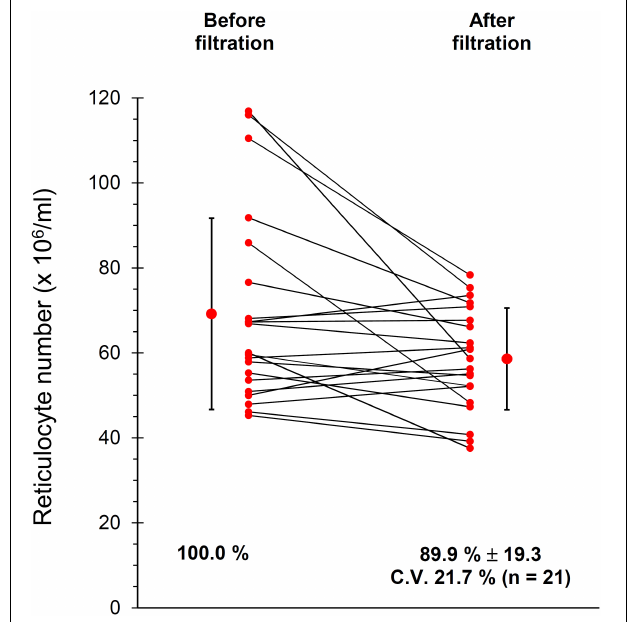
FIGURE 1 | Recovery of Retics after filtration of whole blood through cellulose. Samples of cells as suspensions of approximately 20% Ht, before and after filtration through cellulose were analyzed in 21 independent experiments as described in Materials and Methods section. An average of approximately 10% of Retics was lost during filtration ( n = 21, p = 0.014 at the paired Student’s t -test; CV, coefficient of